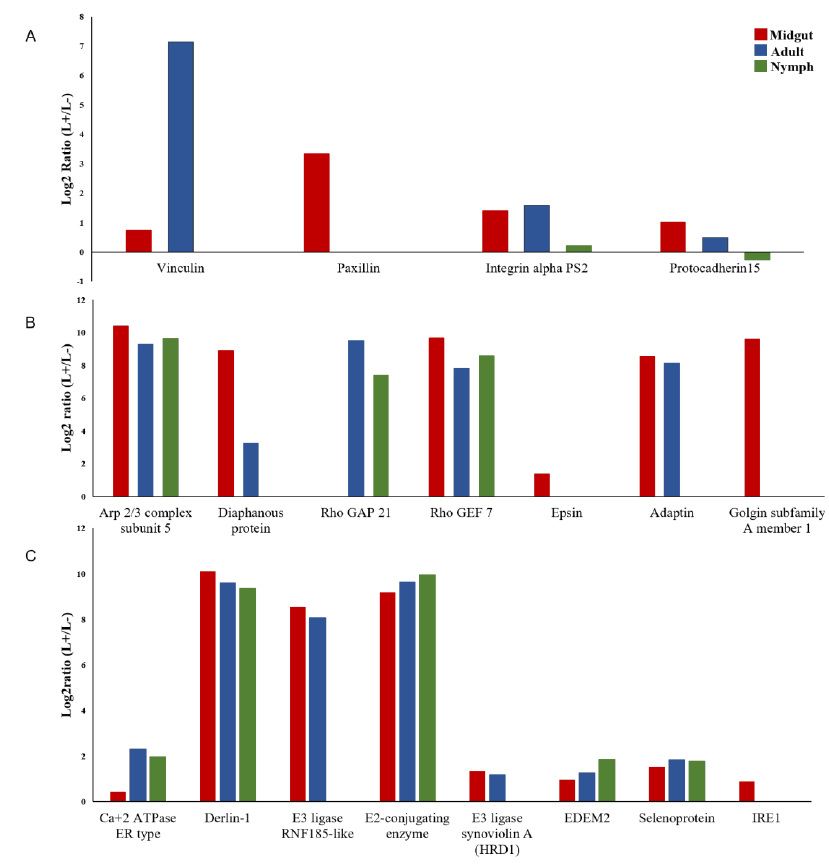
Figure 3. Differentially expressed genes (DEGs) related to CLso pathogenesis in psyllid midguts, nymphs and adults. DEGs related to focal adhesion ( A ), cell invasion and vesicular transport ( B ), and endoplasmic reticulum stress ( C ) are presented. EDEM2 - ER degradation-enhancing alpha-mannosidase-like protein 2; IRE1 - Inositol requiring enzyme 1. Insects 2019 , 10 , x FOR PEER REVIEW Table 4. Differentially expressed genes (FDR ≤ 0.001) between CLso-infected and uninfected midguts, adults, and nymphs related to CLso pathogenesis.